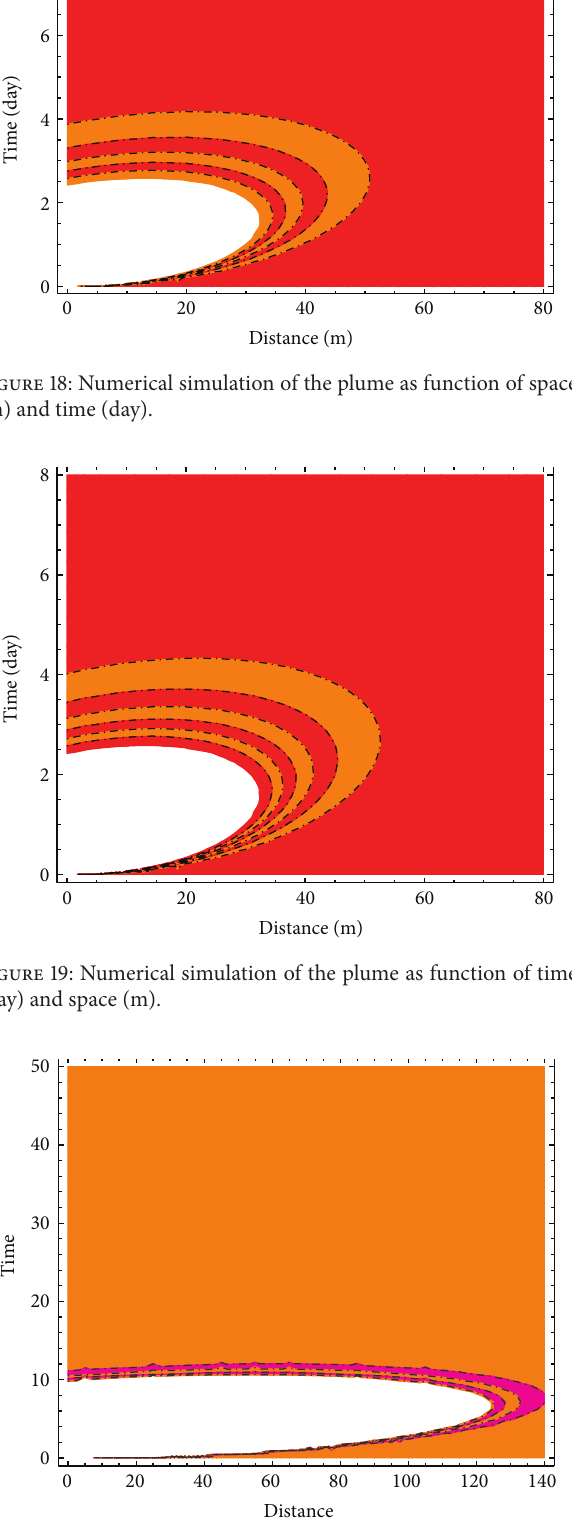
Figure 20: Numerical simulation of the plume as function of time (day) and space